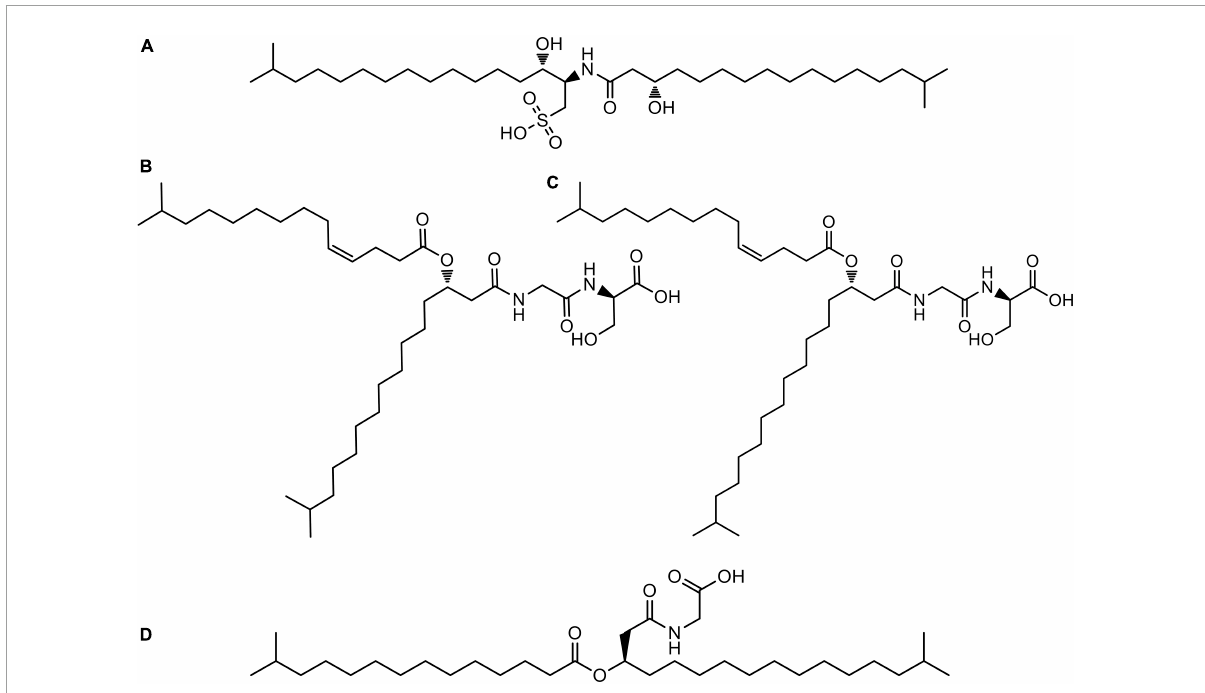
FIGURE7 Structures of compounds tentatively identified in the liquid chromatography hyphenated to UV detection and high-resolution tandem mass spectrometry (HPLC-UV-HRMS) analysis of the lipidic extract of Leeuwenhoekiella parthenopeia Mr9 T : (A) sulfobacin A; (B) WB 3559A; (C) WB 3559B; (D) topostin